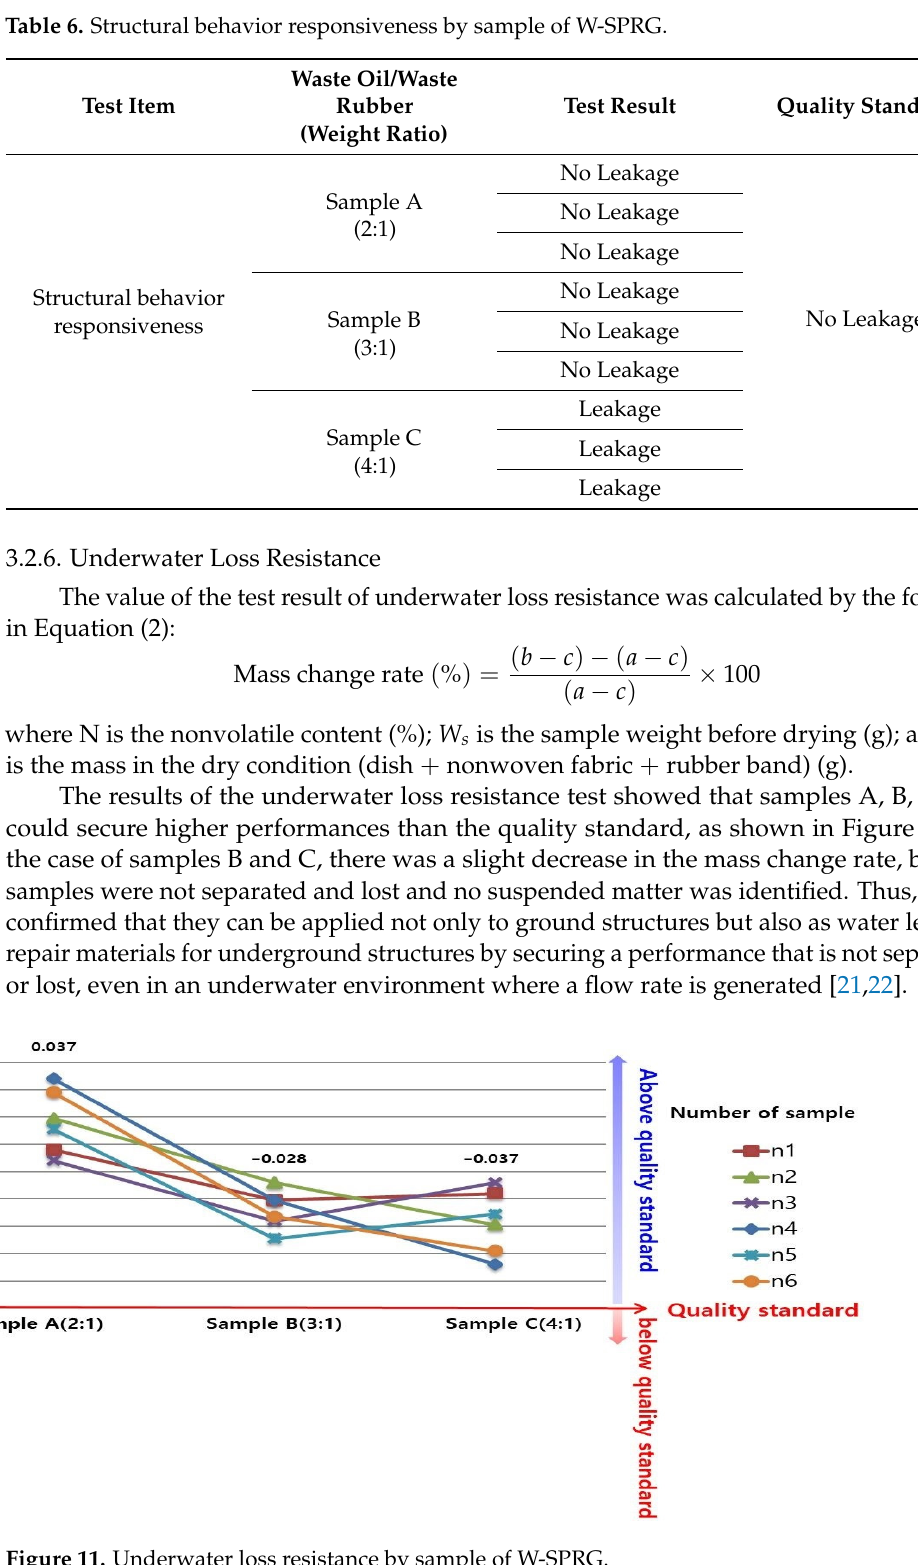
Figure 11. Underwater loss resistance by sample of